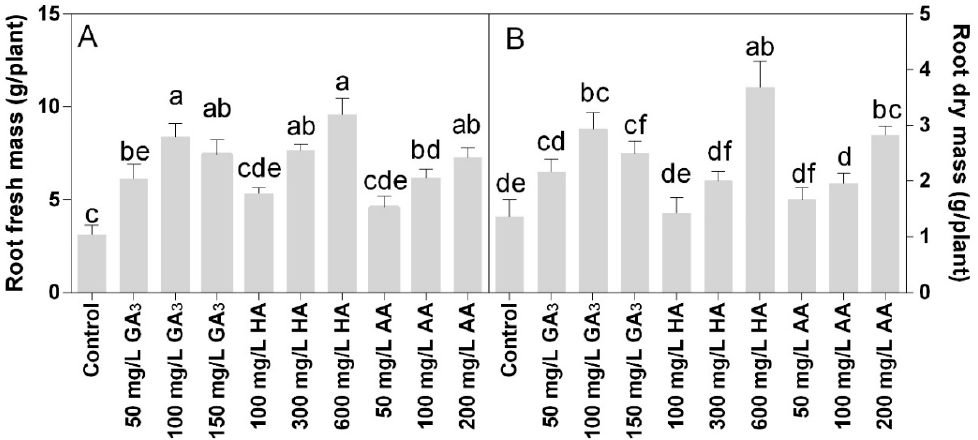
Figure 3. Effect of gibberellic acid (50–100–150 mg L − 1 GA), humic acid (100–300–600 mg L − 1 HA), and ascorbic acid (50–100–200 mg L − 1 AA) foliar applications on the Gazania ( A ) root fresh mass and ( B ) root dry mass. Values are means ± SD ( n = 15). Data were subjected to the Kruskal-Wallis test. Differences among means were determined using Dunn’s multiple comparisons test. Significant differences ( P < 0.05) among bioregulators foliar treatments are indicated by different letters. Shoot mass fraction was only significantly higher in 100 mg L − 1 GA 3 treatment compared to the control (Figure 4A). The root mass fraction and the root-shoot ratio were lower at the higher doses of GA 3 treatments or 200 mg L − 1 AA compared to the other treatments (Figure 4B,C). The highest values were found in the 100 and 300 mg L − 1 HA.